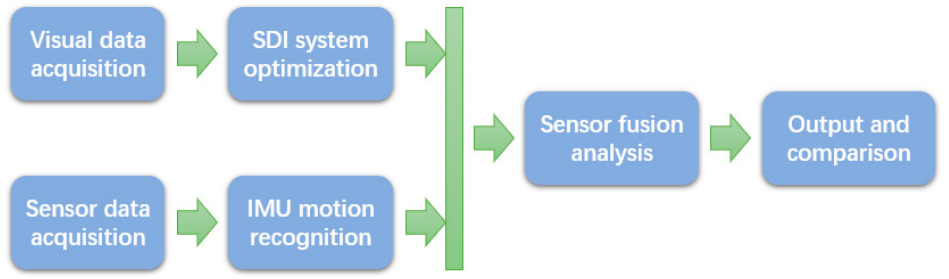
Figure 1. Overview of the proposed methodology .